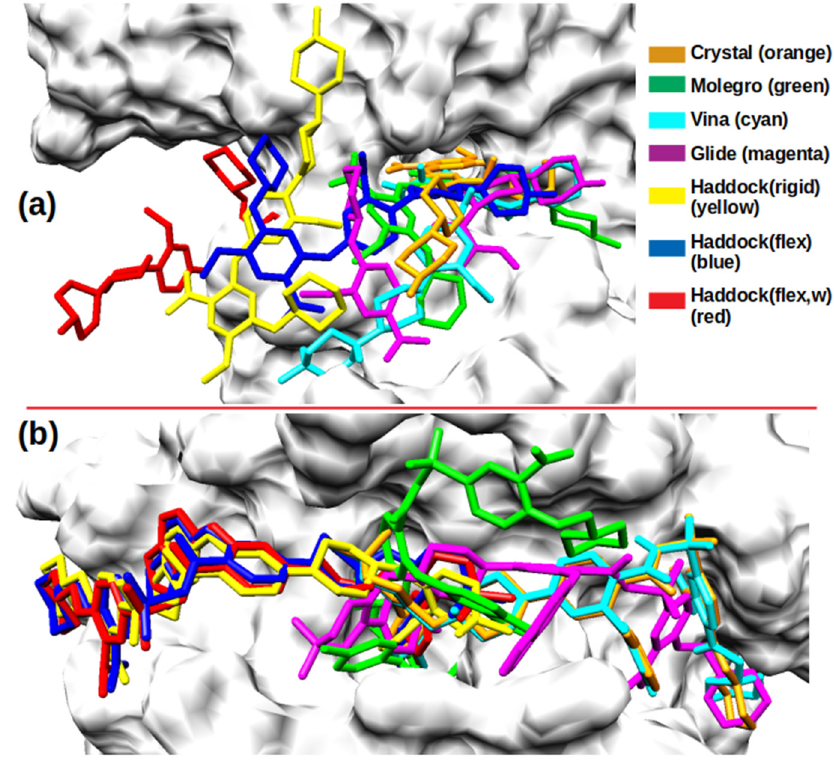
Figure 4. The binding site orientation of ( a ) gilteritinib to FLAT3 and ( b ) venetoclax to BCL-2 obtained from Molegro (green), Vina (cyan), Glide (magenta), Haddock(rigid) (yellow), Haddock(flex) (blue), and Haddock(flex, water) (red), in relation to their crystal structure crystal (orange).